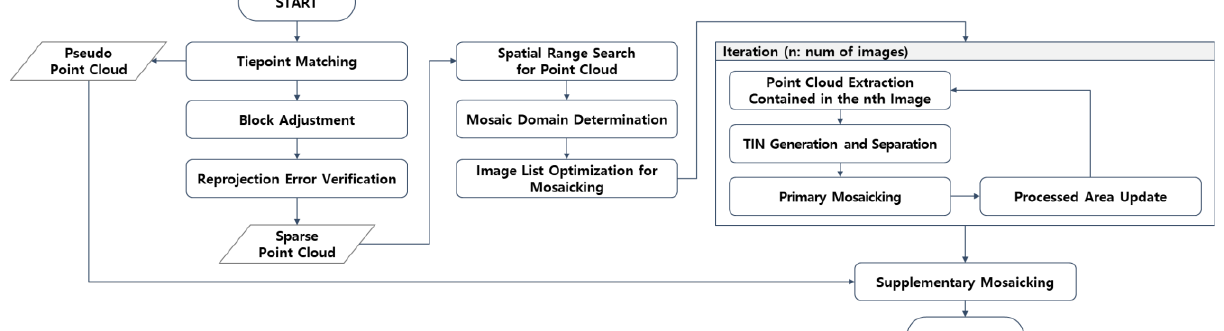
Figure 1. Flowchart of the proposed method